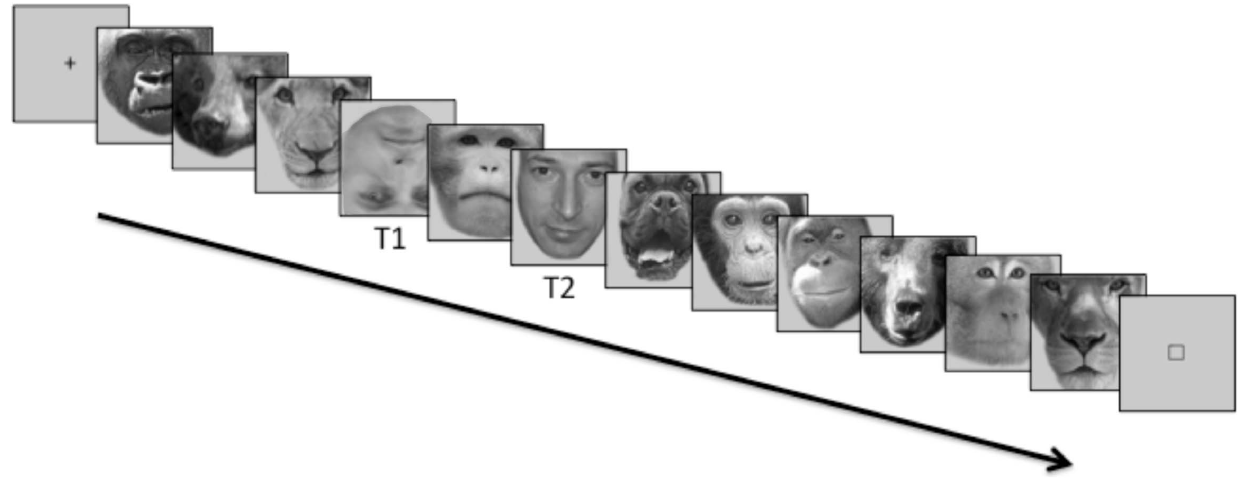
Figure 1. Attentional blink paradigm. Faces of different categories of mammals were used as distracters while human faces were presented as targets. The first target (T1) was an inverted face (always a face of a stranger different from those used as T2) and the second target (T2) was an upright face that was either a personally familiar face or the face of a stranger. Stimuli were presented for 80 ms with no interval between stimuli.